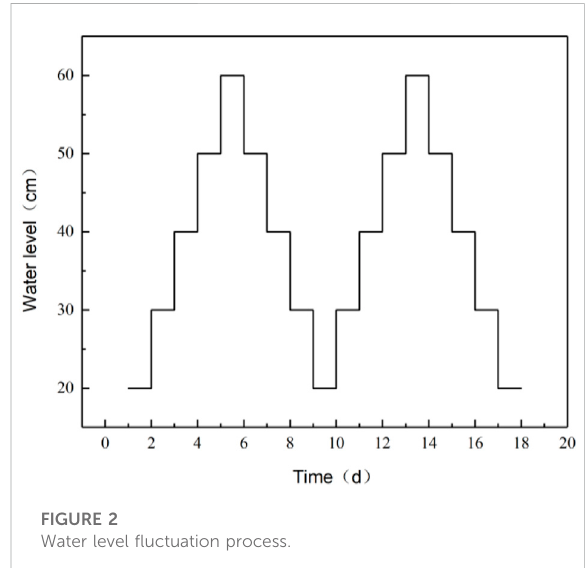
FIGURE 2 Water level fl uctuation